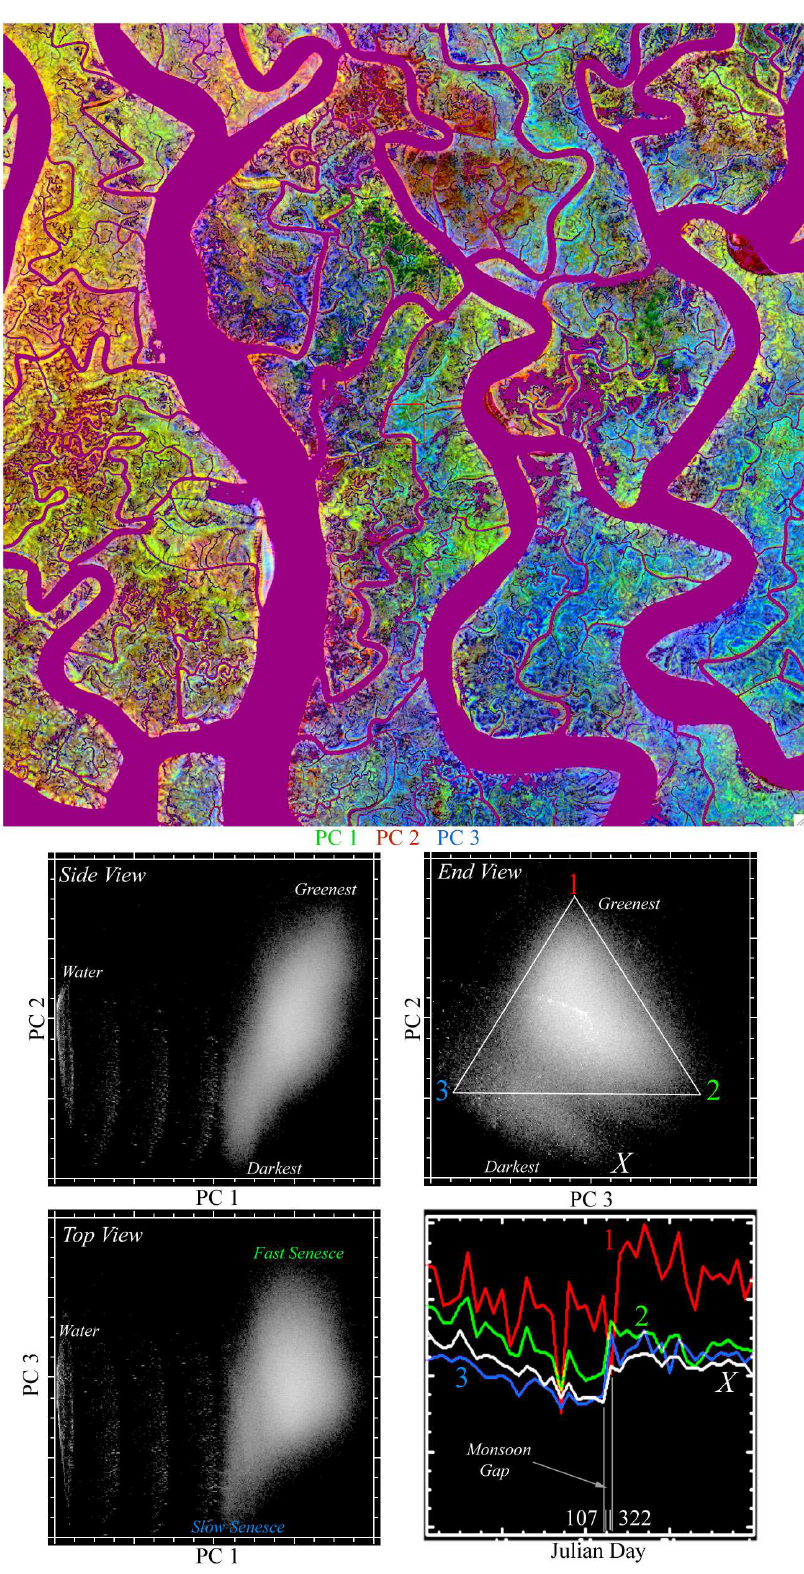
Figure 8. Temporal feature space and PC map of 10 × 10 km substack from Figure 4. The PC map shows spatially coherent structure resulting from distinct combinations of PCs 1–3. The feature space (bottom) clearly separates water from forest, spanning 3 distinct senescent phenologies at apexes of PC 3 / 2